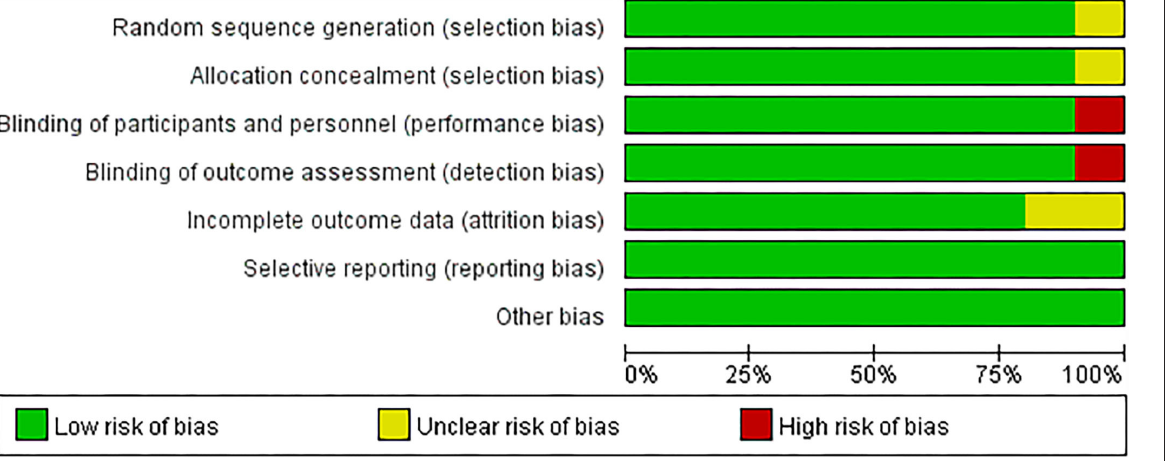
FIGURE3 The risk of bias graph.